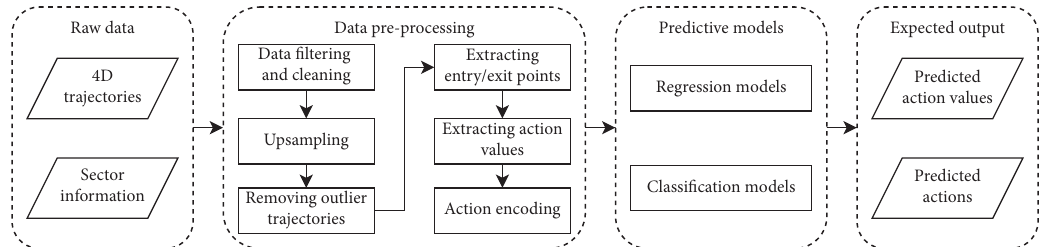
Figure 1: The illustration of our approach for building predictive models.